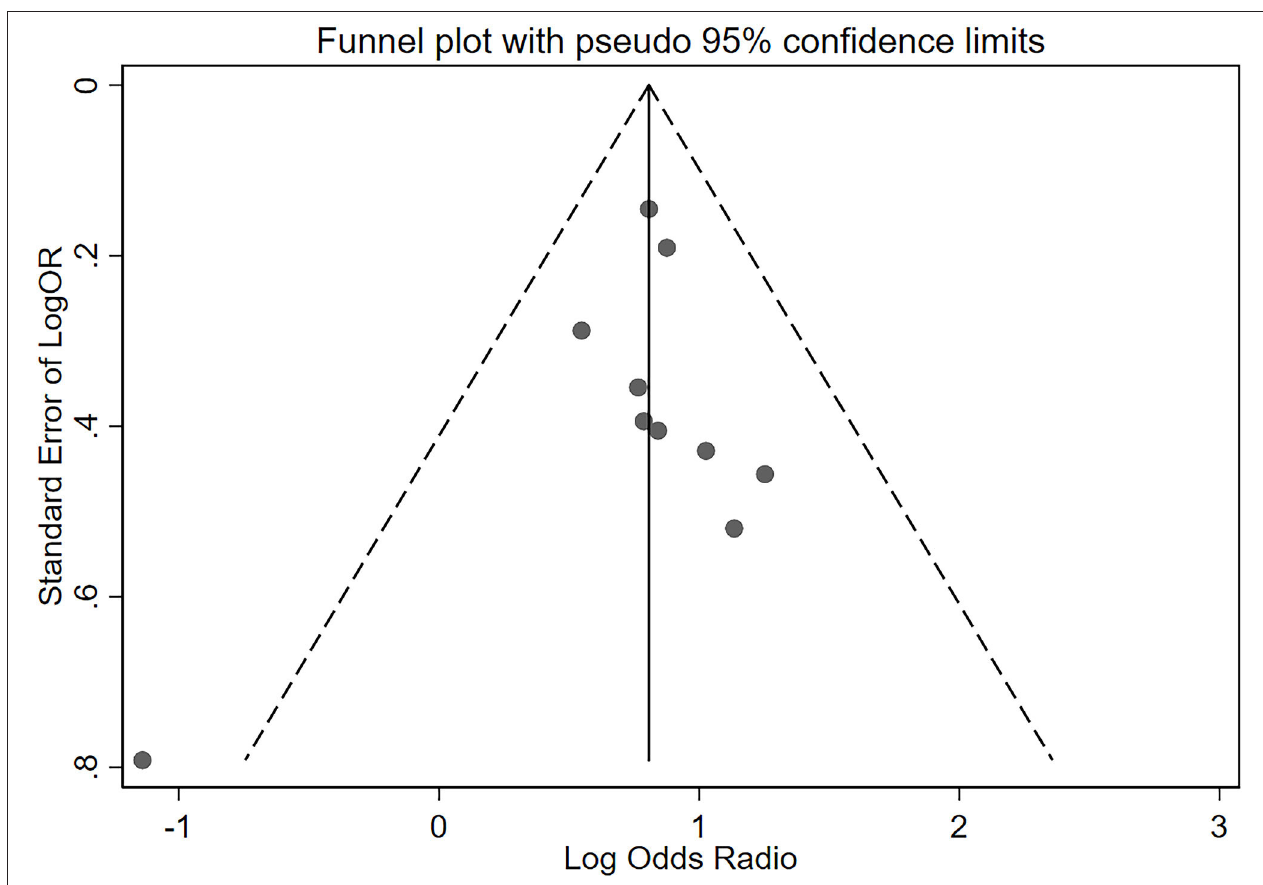
FIGURE 4 | Funnel plot of standard error of log odds ratio (OR) for the association of diabetic retinopathy and cognitive impairment. The vertical line represents the summary estimate of log OR. Diagonal dashed lines estimate the expected distribution of studies; The Egger test did not show statistically significant asymmetry of the funnel plot ( P =